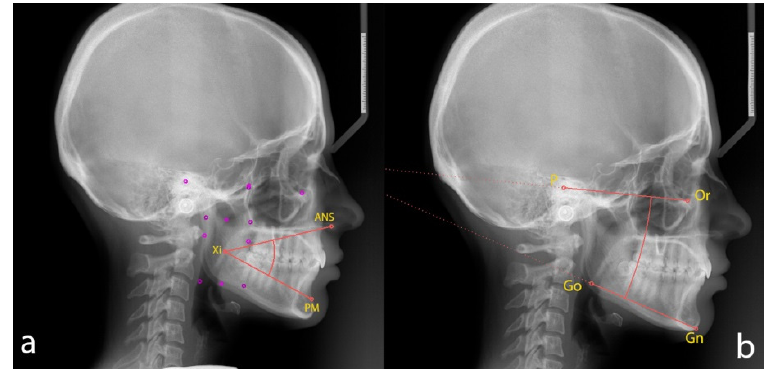
Figure 1. Cephalometric analysis: ( a ) The lower facial height angle [LFHˆ], between anterior nasal spine [ANS], [Xi] point and prementon [PM]; ( b ) The angle [MLˆFH], between mandibular plane (gnathion [Gn]–gonion [Go]) and Frankfurt plane (porion [P]–orbitale [Or]).